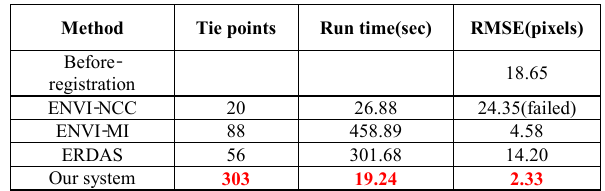
Figure 6 A pair of very large SAR and Optical images